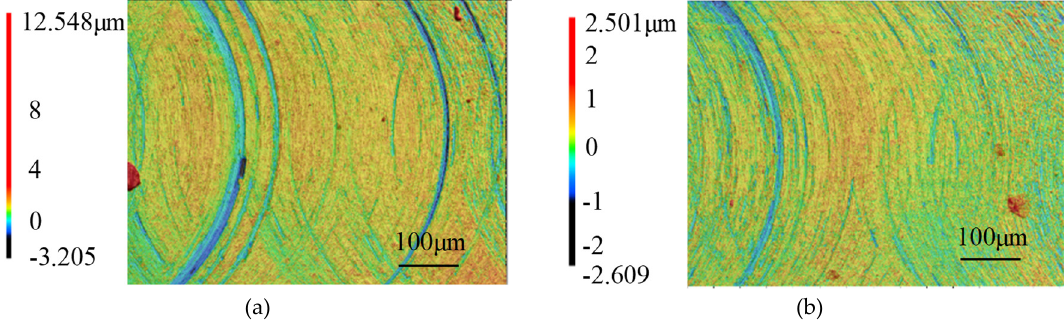
Figure 13. The surface morphology for aluminum material. ( a ) Feed rate of 2 μ m/tooth; ( b ) feed rate of 3 μ m/tooth.